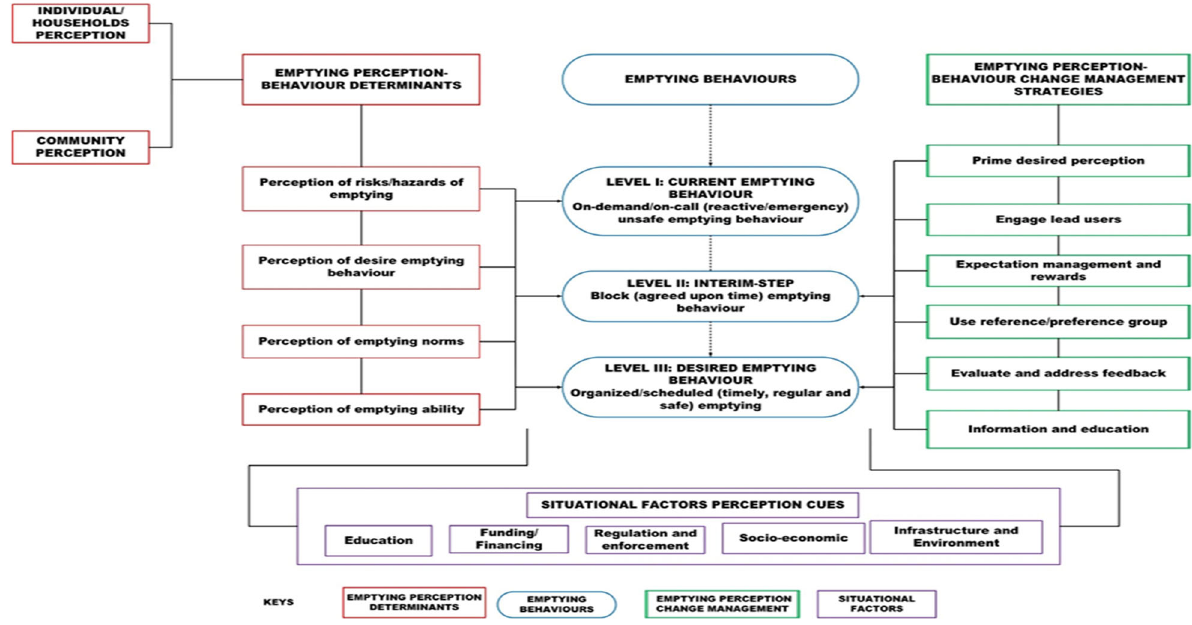
Fig. 9 Emptying perception change management model (EPeCMD) for non-sewered sanitation containment systems towards the achievement of scheduled emptying behaviour. It is a proposed model that shows a pathway for using perception management for behaviour change strategies in onsite sanitation systems/non-sewered sanitation systems (OSS/NSS)